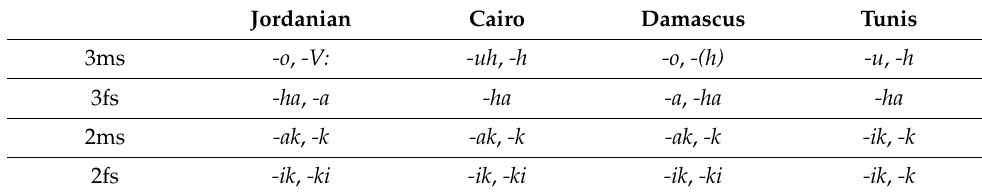
Table 1. Levantine and N. African Singular Pronominal Suffixes. Jordanian Cairo Damascus Tunis 3ms -o , -V: -uh , -h -o , -(h) -u ,